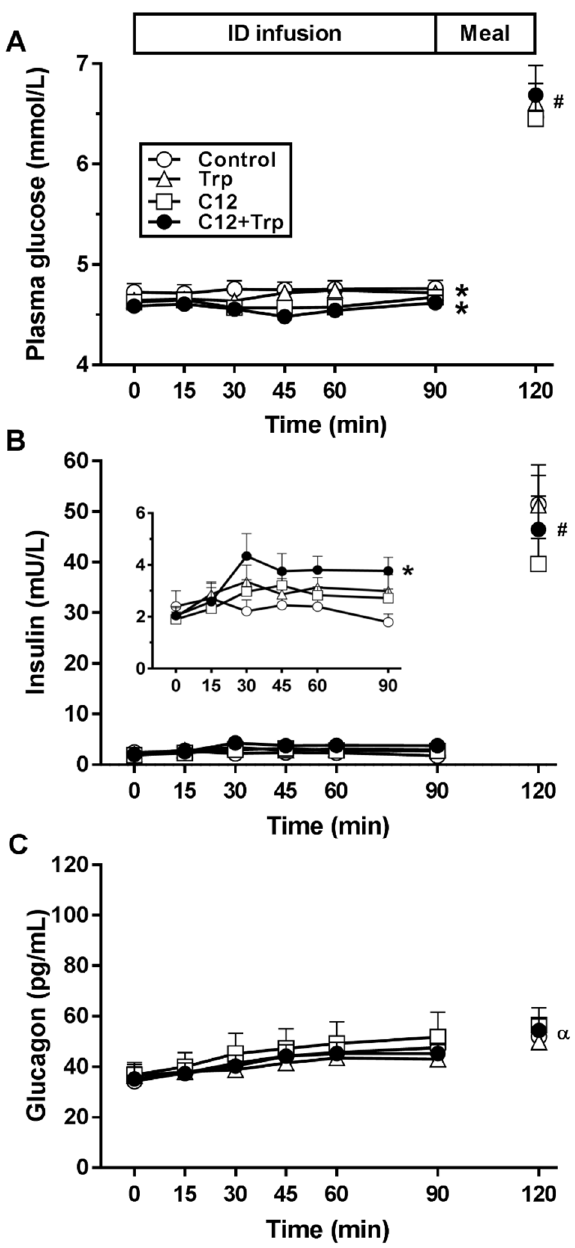
Figure 1. Plasma glucose ( A ), insulin ( B ), and glucagon ( C ) concentrations during duodenal administration of lauric acid (“C12”; 0.3 kcal/min), L-tryptophan (“Trp”; 0.1 kcal/min), a combination of C12 and Trp (“C12+Trp”; 0.4 kcal/min), or isotonic saline (“control”), for 90 min and, at t = 120